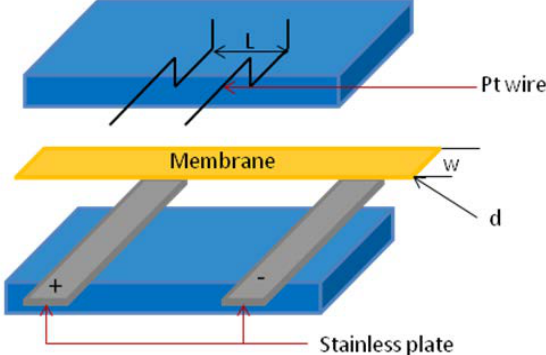
Figure 1. Scheme of proton conductivity measurement